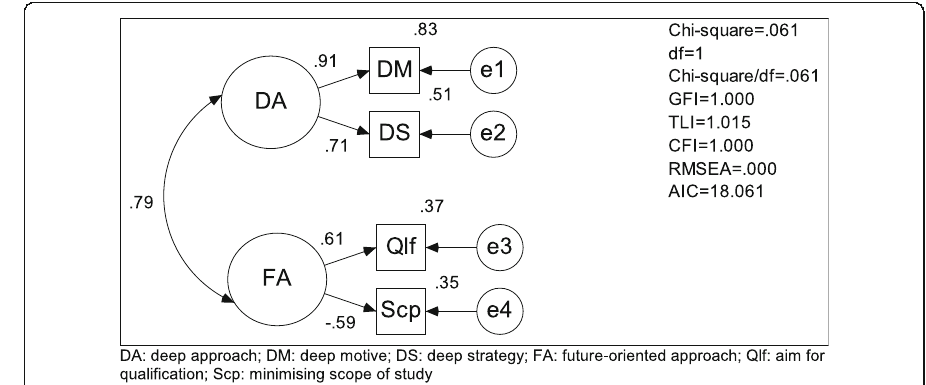
Fig. 5 The measurement model of deep approach and future-oriented approach derived from item